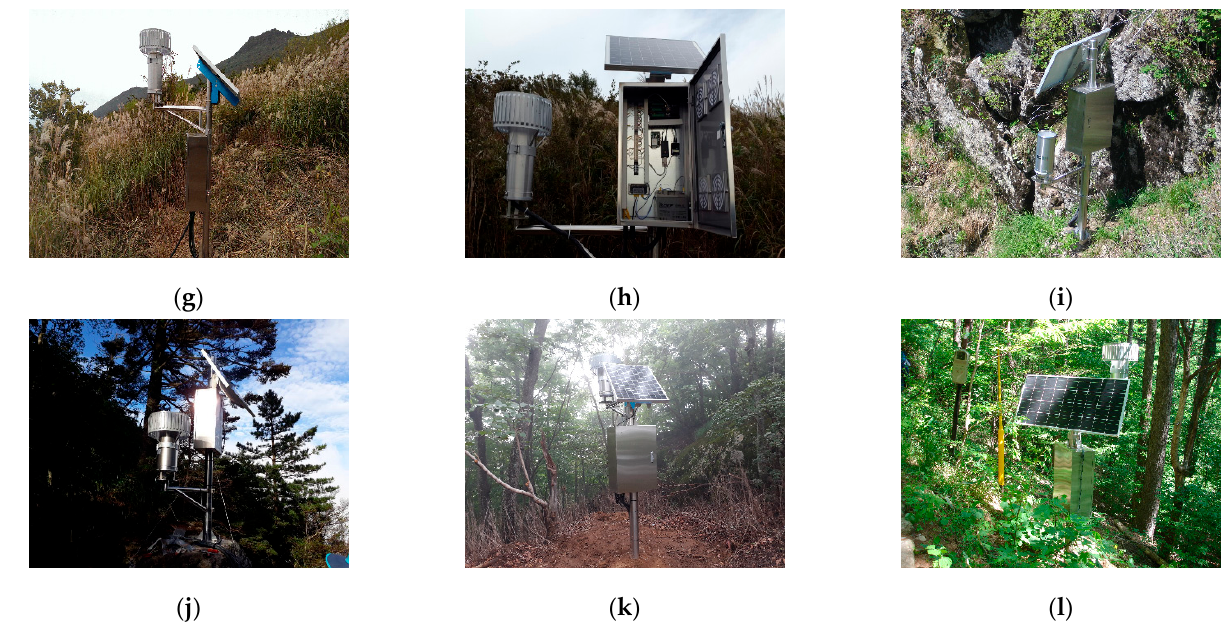
Figure 4. Twelve landslide monitoring stations installed across eight national parks: ( a ) Seoraksan (Baekdamsa); ( b ) Seoraksan (Huiungak); ( c ) Juwangsan; ( d ) Songnisan; ( e ) Gyeryongsan; ( f ) Deogyusan; ( g ) Mudeungsan; ( h ) Wolchulsan; ( i ) Jirisan (Jeseokbong); ( j ) Jirisan (Jungbong); ( k ) Jirisan (Rotary Shelter); ( l ) Jirisan (Jungsalli).